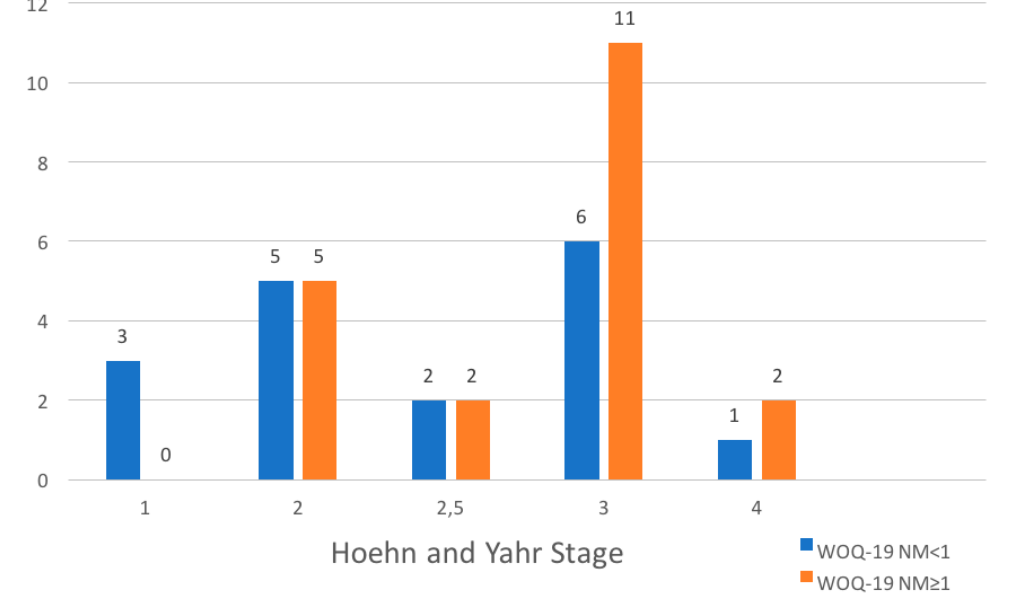
Figure 1. Comparison of the frequency of non-motor symptoms fluctuation and disease severity (H&Y).